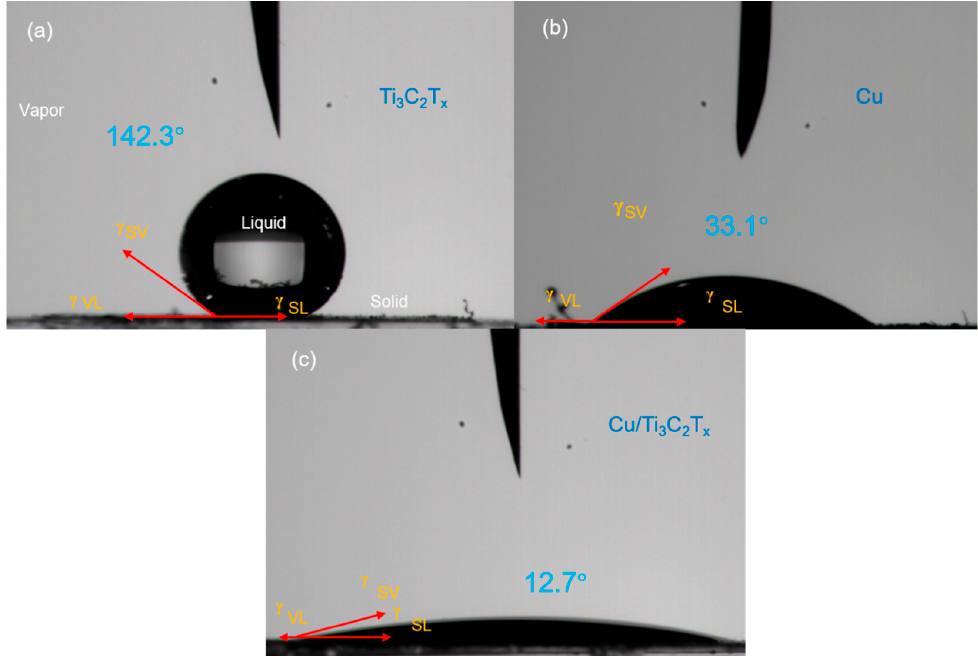
Figure 7. The contact angle test of Ti 3 C 2 T x , Cu and Cu/Ti 3 C 2 T x ; ( a ) Ti 3 C 2 T x , ( b ) Cu and ( c ) Cu/Ti 3 C 2 T x .